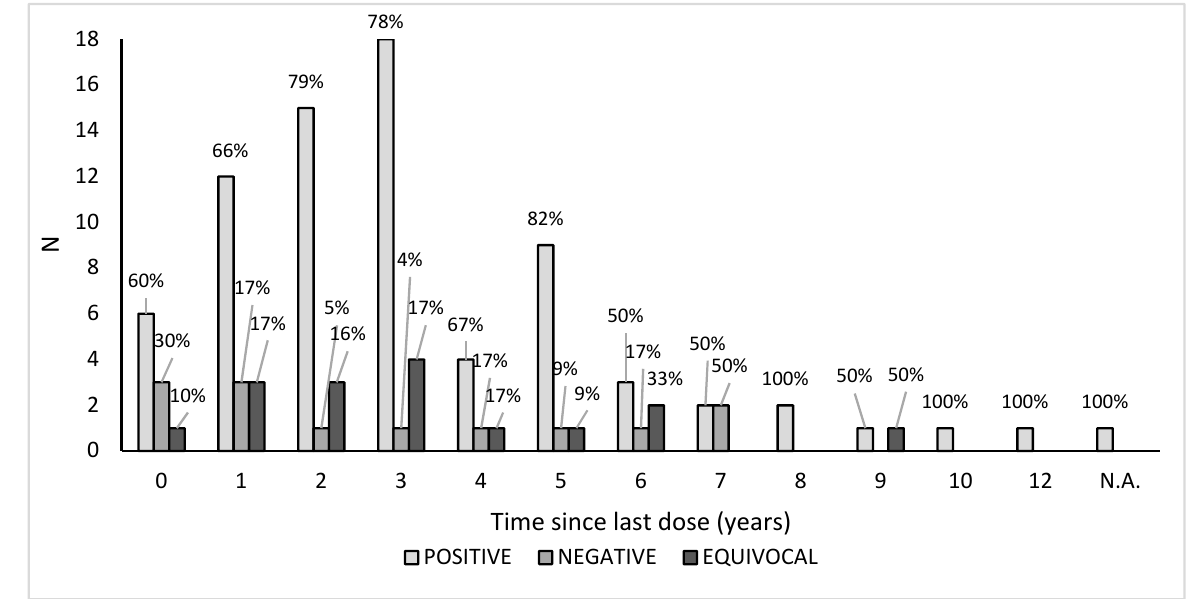
Figure 3. Seroprevalence related to the time (years) elapsed since the last dose of vaccine received. N.A.: not available.